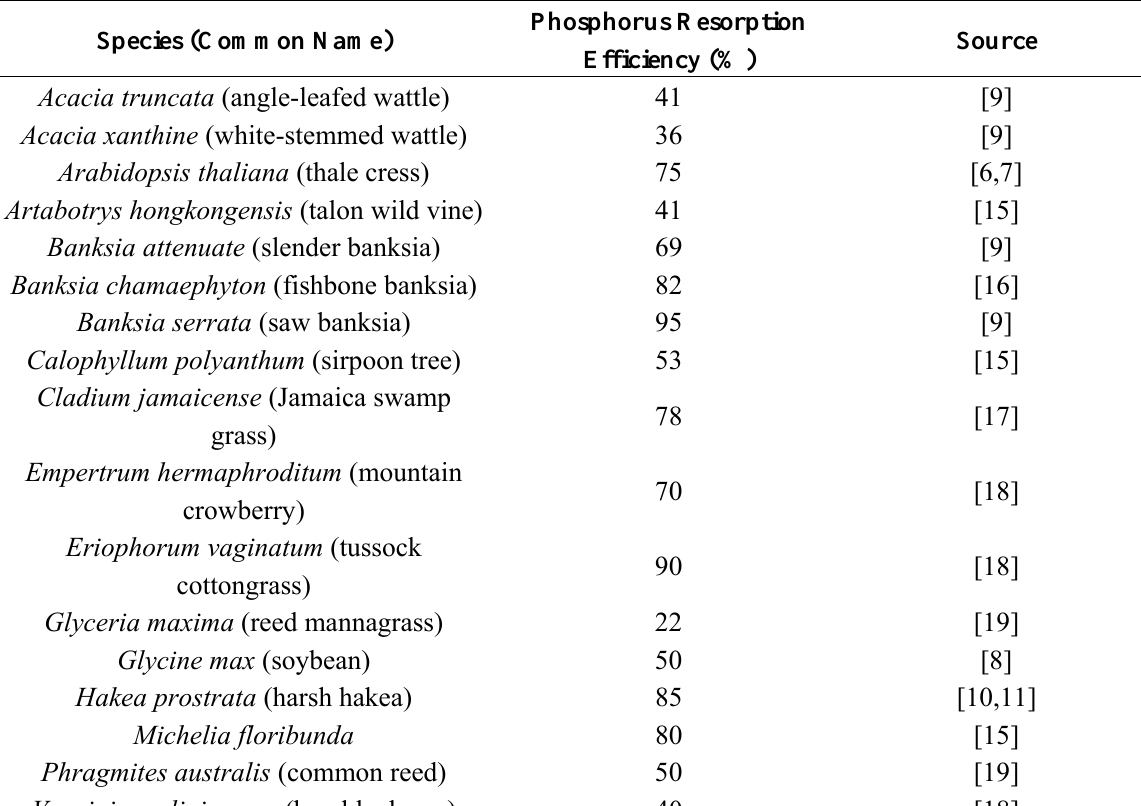
Table 1. A comparison of phosphorus (P) resorption efficiencies across a variety of plant species, where P resorption efficiency is defined as the amount of total P resorbed during senescence (expressed as a percentage of the total amount of P present in a fully-expanded, leaf relative to a fully senesced leaf)